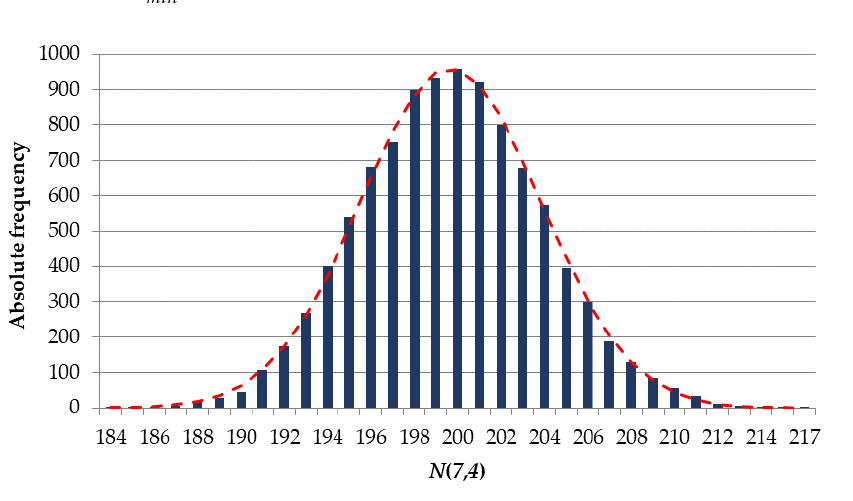
Figure 3. Histogram of the distribution of a random value ( ) 7,4 N .